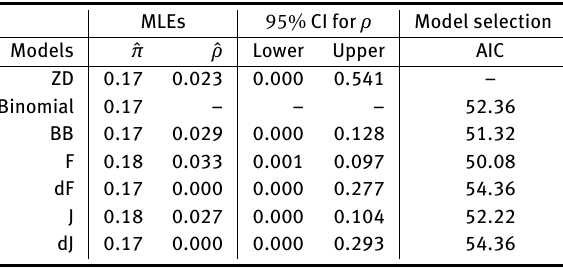
Table 7: Six set of estimators for a community intervention